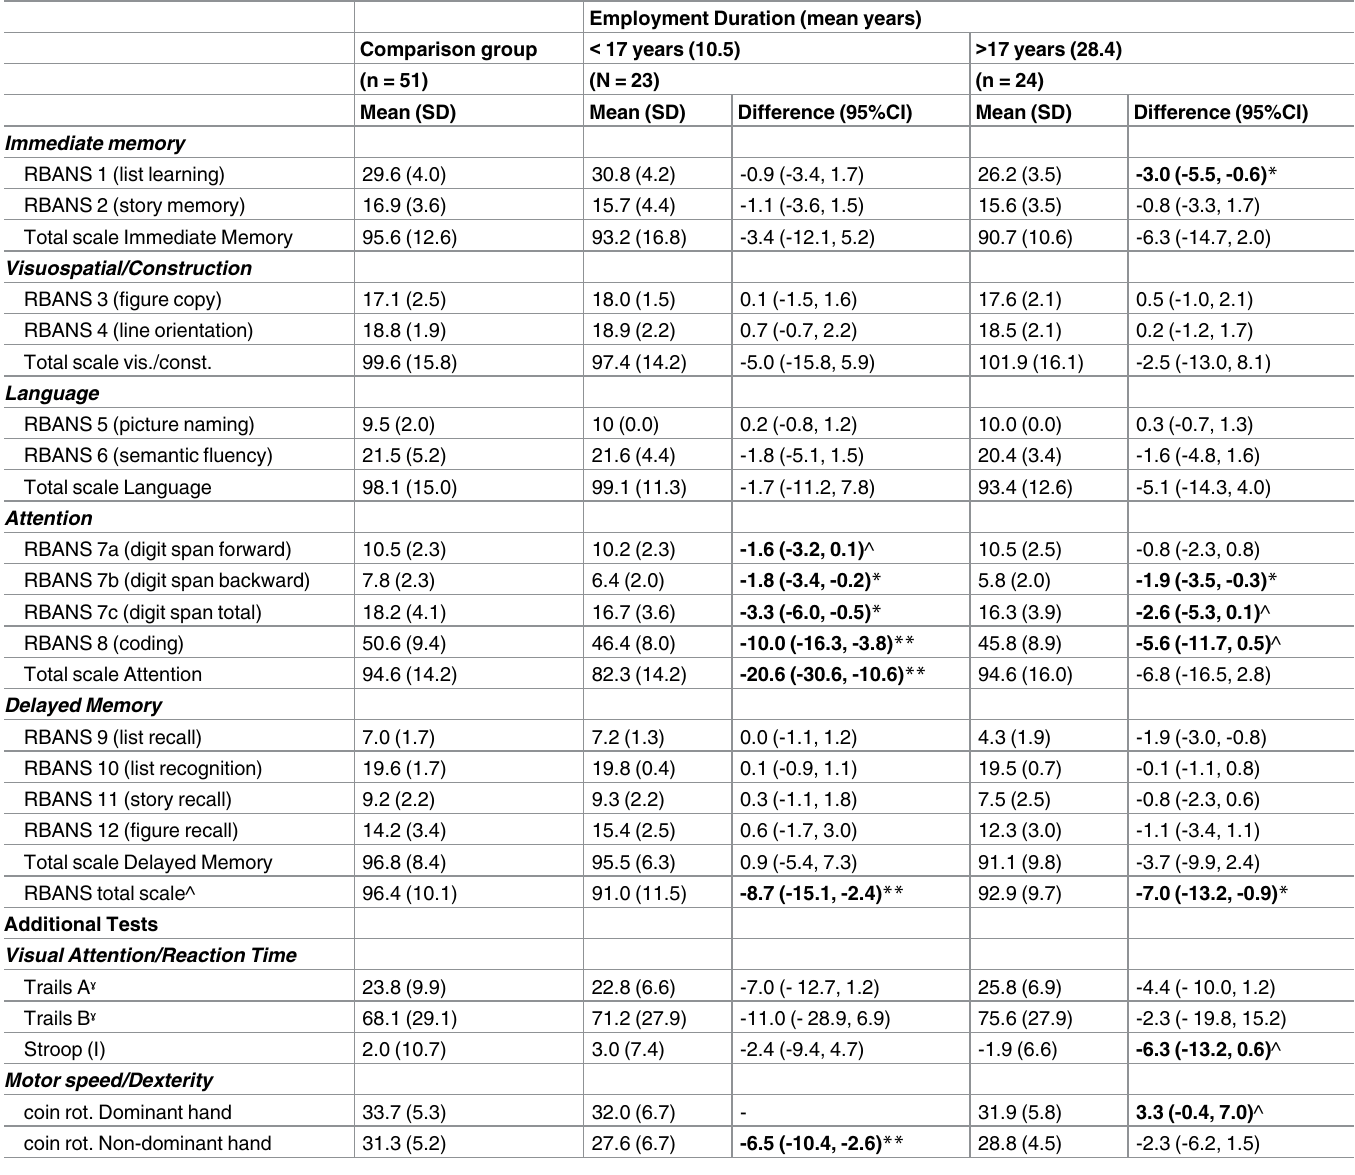
Table 4. Neuropsychological test scores for collision repair workers stratified by employment